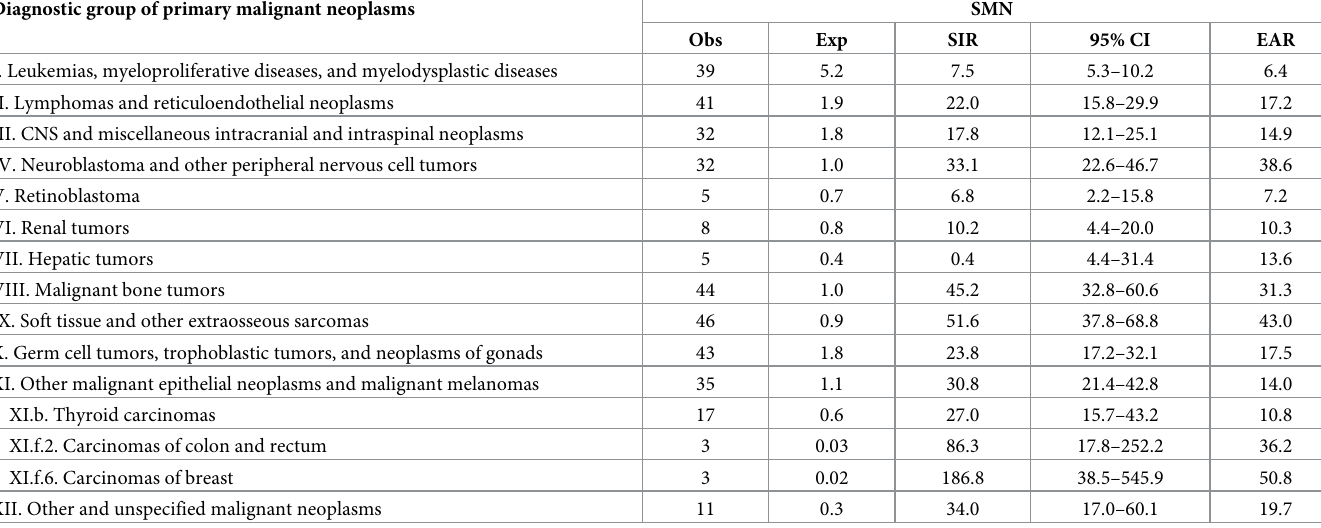
Table 3. SMN occurrence according to primary cancer